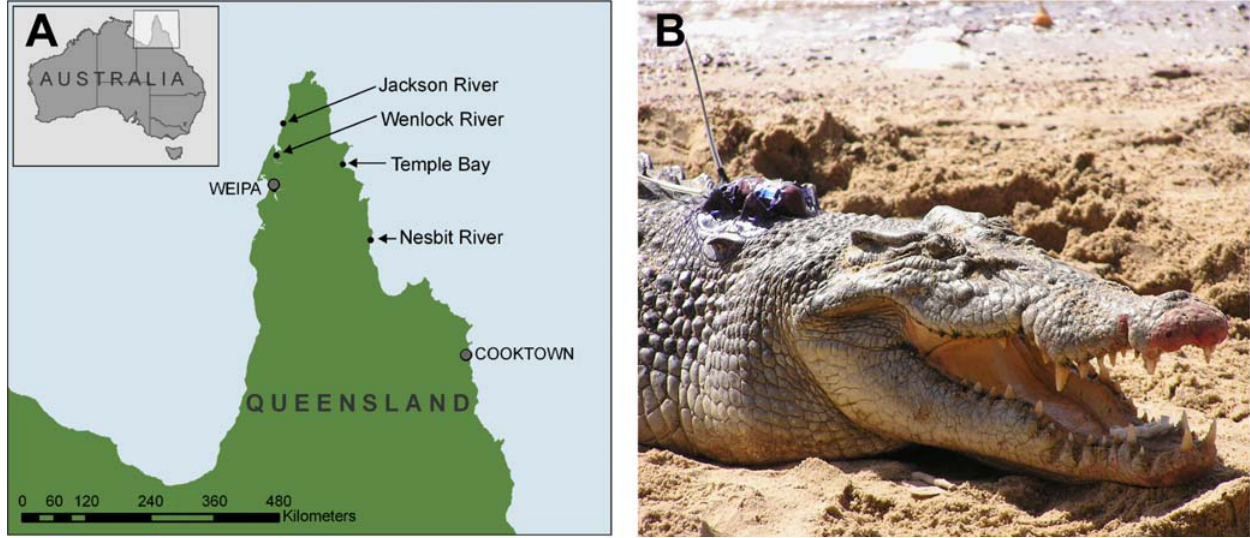
Figure 1. Location of study sites and position of a satellite transmitter on an estuarine crocodile. A Map of Queensland, Australia showing the study sites and capture locations of the three crocodiles that were translocated. B A large, male estuarine crocodile ( Crocodylus porosus ) with a satellite transmitter attached between the nuchal scutes. doi:10.1371/journal.pone.0000949.g001 Table 2. Argos location classes and number of fixes for three male Crocodylus porosus .. ... .... ... ... .... ... ... .... ... ... .... ... ... .... ... ... .... ... ... .... ... ... .... ... ... .... ... ... .... ... ... .... ... ... .... ... ... .... ... ... .... ... ... . Argos Location